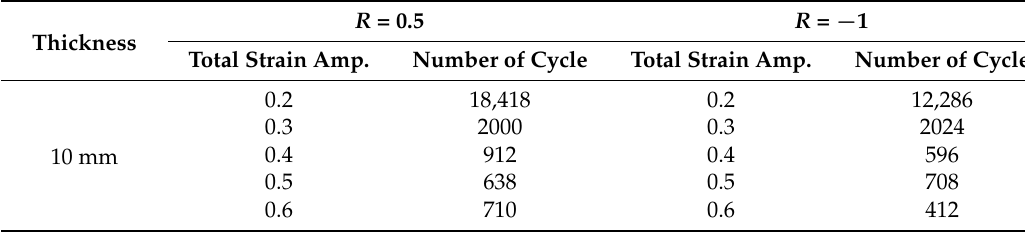
Table A2. Summary of low-cycle fatigue test results for two different strain